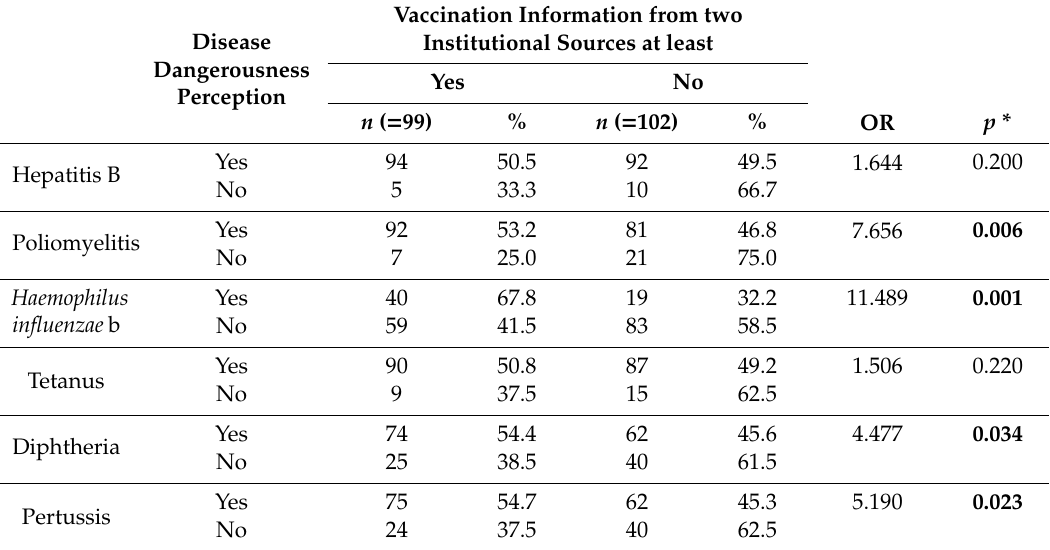
Table 3. Perception of risk related to vaccine-preventable infectious disease according to the type of information source: institutional or